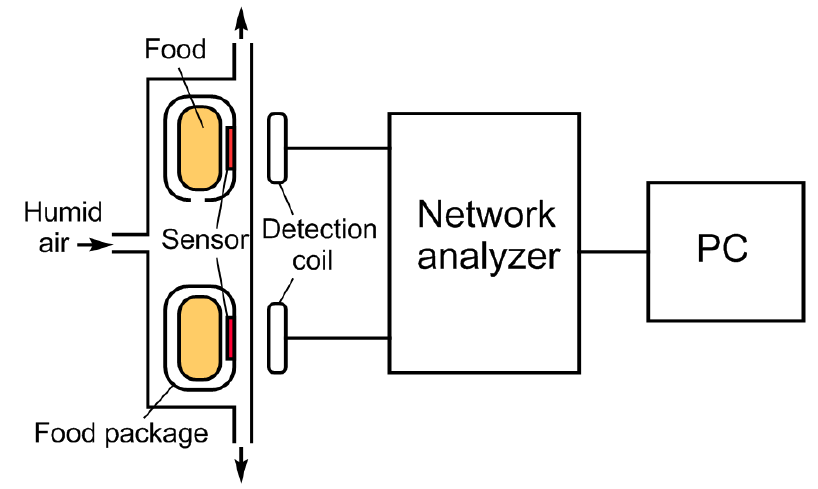
Figure 6. Experimental setup for demonstrating the application of the LC sensor for real- time food quality monitoring.